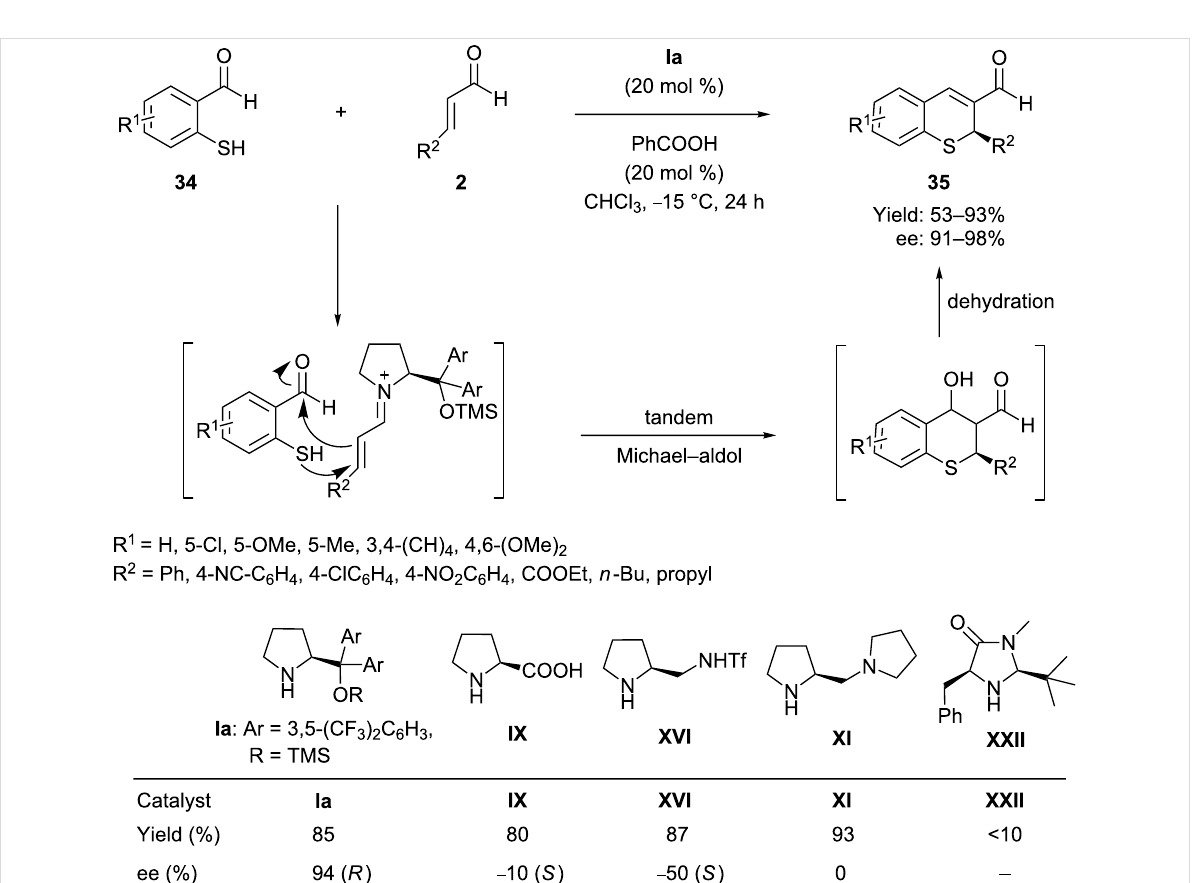
Scheme 18: ( S )-diphenylpyrrolinol silyl ether-promoted cascade thio - Michael–aldol reactions, as reported by